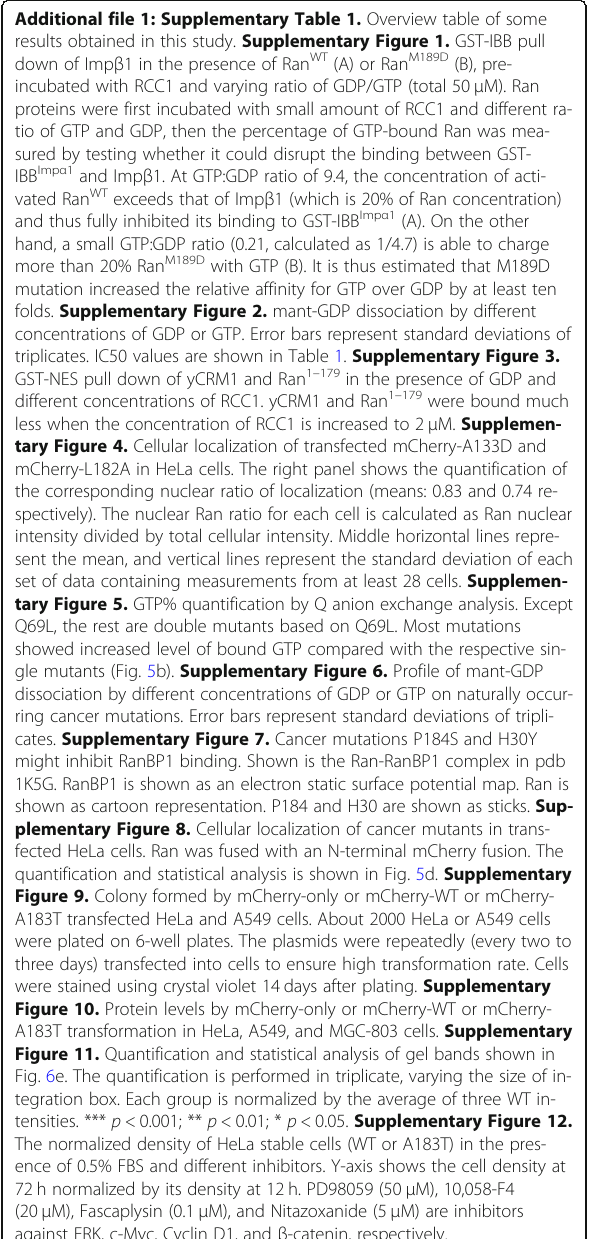
Figure 10. Protein levels by mCherry-only or mCherry-WT or mCherry- A183T transformation in HeLa, A549, and MGC-803 cells. Supplementary Figure 11. Quantification and statistical analysis of gel bands shown in Fig. 6e. The quantification is performed in triplicate, varying the size of in- tegration box. Each group is normalized by the average of three WT in- tensities. *** p <0.001; ** p < 0.01; * p < 0.05. Supplementary Figure 12. The normalized density of HeLa stable cells (WT or A183T) in the pres- ence of 0.5% FBS and different inhibitors. Y-axis shows the cell density at 72h normalized by its density at 12h. PD98059 (50 μ M), 10,058-F4 (20 μ M), Fascaplysin (0.1 μ M), and Nitazoxanide (5 μ M) are inhibitors against ERK, c-Myc, Cyclin D1, and β -catenin,